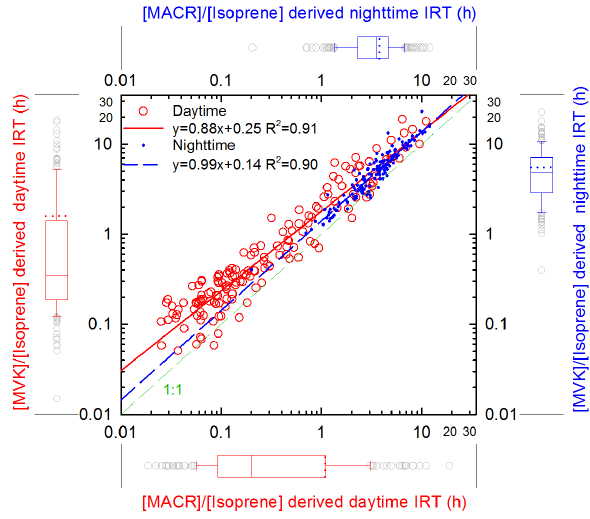
Figure 6. Isoprene reaction time (IRT) derived from [MVK] / [isoprene] and [MACR] / [isoprene] based on the modelled OH and NO 3 concentrations. The green dashed line denotes a 1:1 relationship. Next to axes are the box and whisker plots of each result, and the dotted lines denote the mean